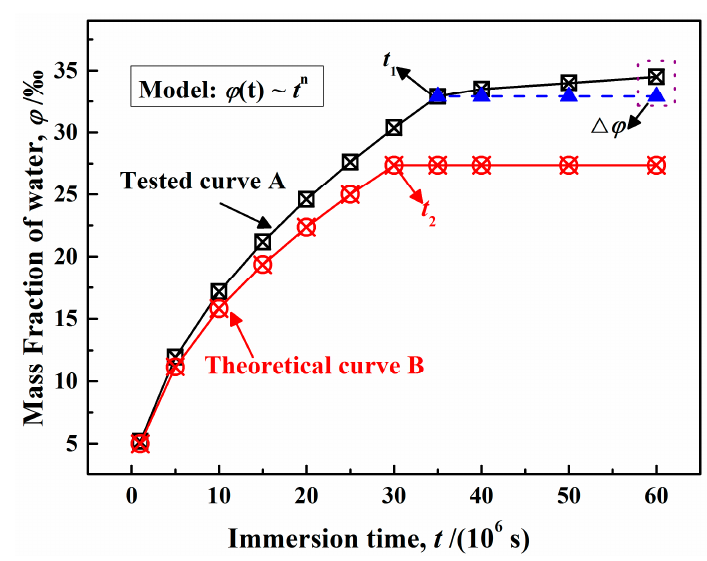
Figure 3. Analysis of error between experimental and theoretical values.